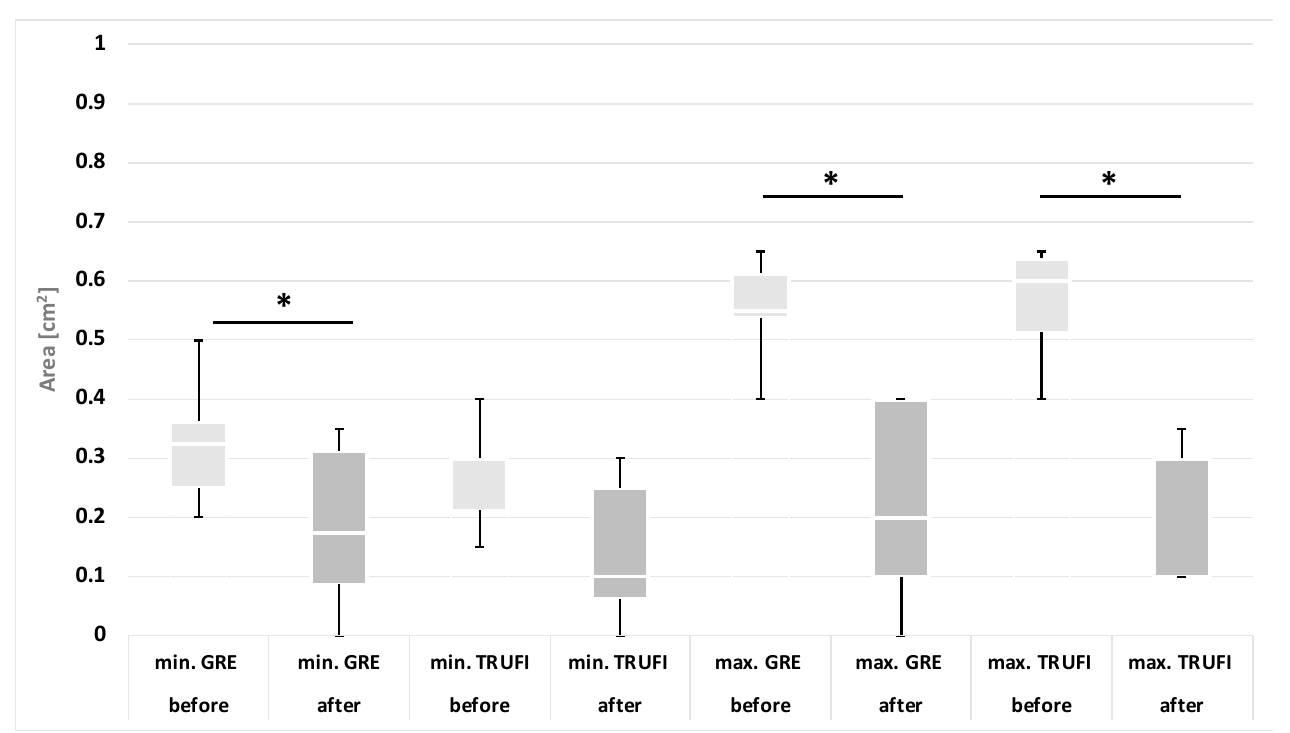
Figure 5. The minimum and maximum values of glottic angles in patients without changes in the mobility VF after surgery in relation to the preoperative examination with the use of US and MRI sequences (GRE and TRUFI).